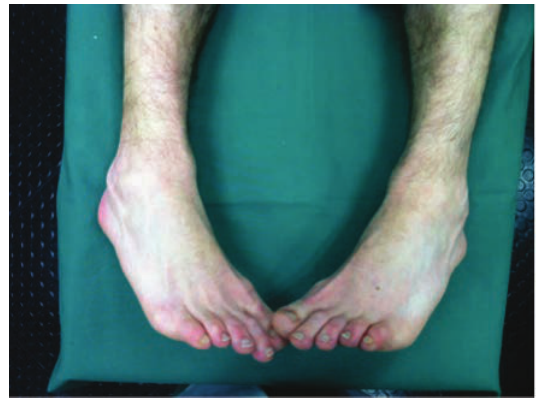
Figure 1. Inconspicuous superficial view comparing injured (right) with uninjured side (left), maximum inversion